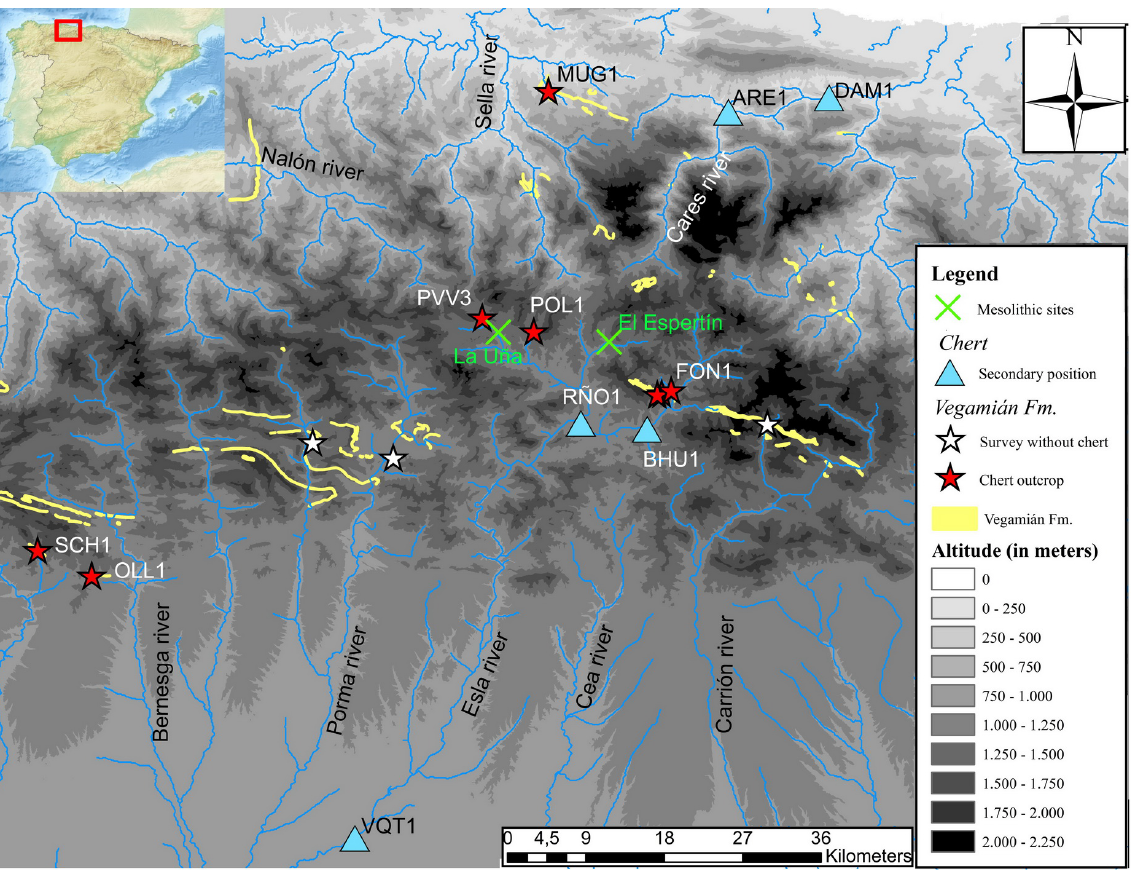
Figure 3: General distribution map of the Vegamián Formation in the Cantabrian zone. Red stars: chert outcrops in primary source. White stars: Vegamián Formation without chert. Triangles: secondary deposits of ‘black cherts’. Crosses: archaeological sites. (Source: altitude maps are taken from Centro Nacional de Información Geográfica-CNIG; rivers from Infraestructura de Datos Espaciales de España-IDEE and geological distribution of Vegamián Fm. from Instituto Geológico y Minero de España-